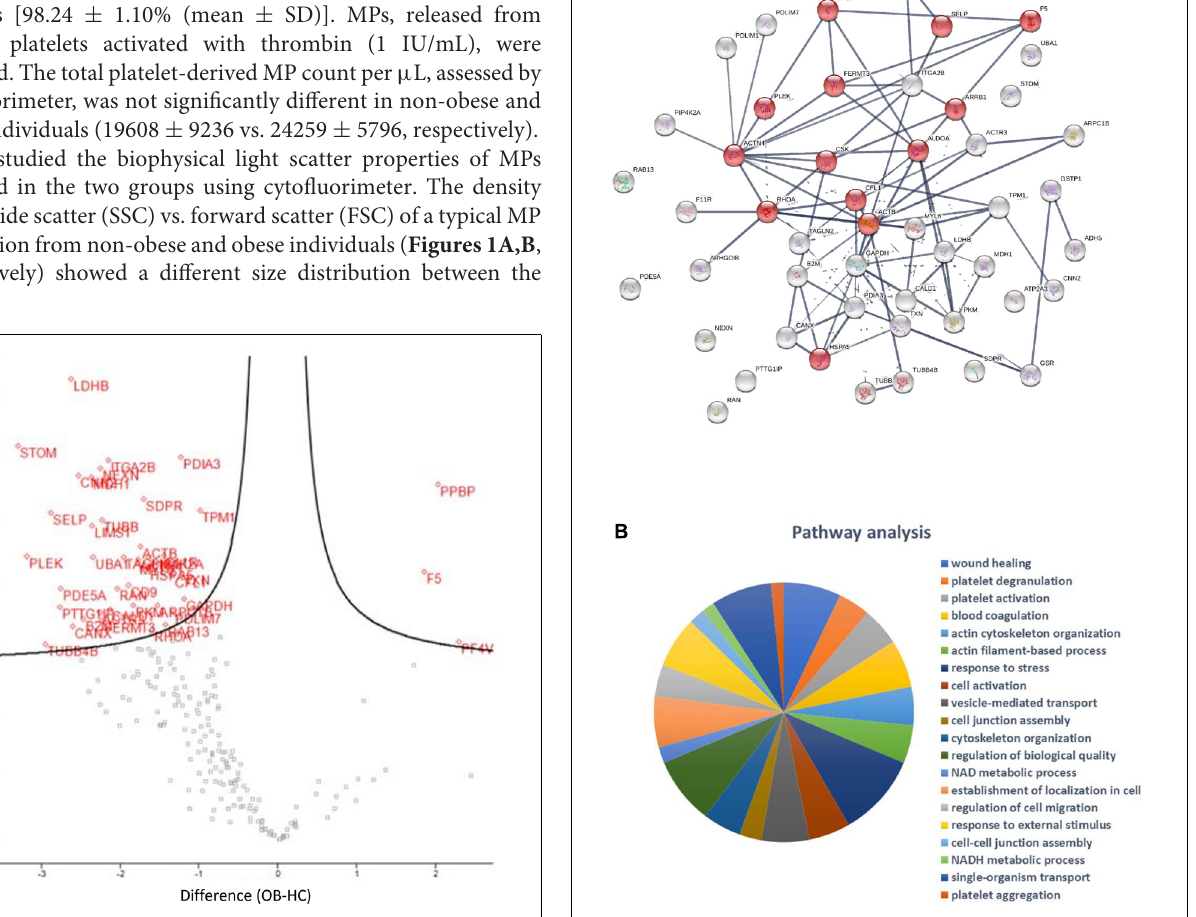
Frontiers in Pharmacology |